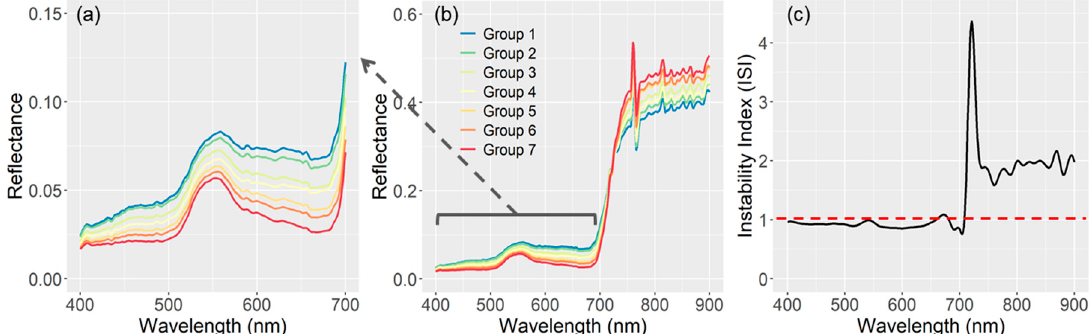
Figure 9. ( a , b ) Mean spectra of the seven groups with different low to tall shrub PFT fractional covers. ( c ) Instability index (ISI) calculated among the seven groups. Low to tall shrub PFT fractional cover: group1: 0–10%; group 2: 10–20%; group 3: 20–30%; group 4:30–40%; group 5: 40–50%; group 6: 50–60%; group 7: 60–68%.